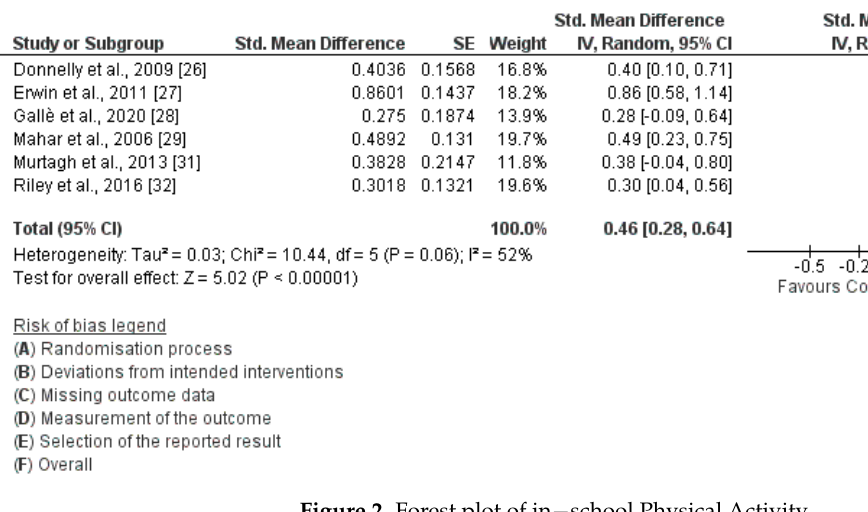
Figure 2. Forest plot of in − school Physical Activity .